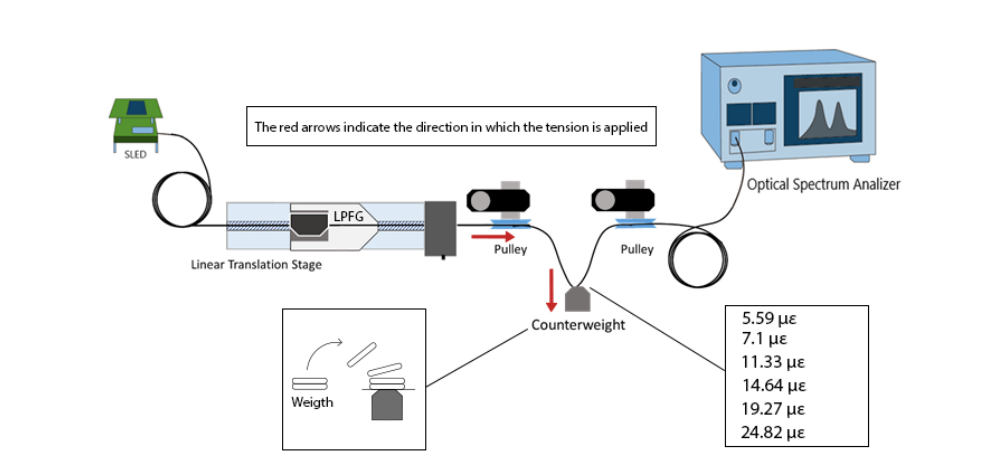
Figure 11. Experimental setup used for strain characterization of engraved LPFGs.